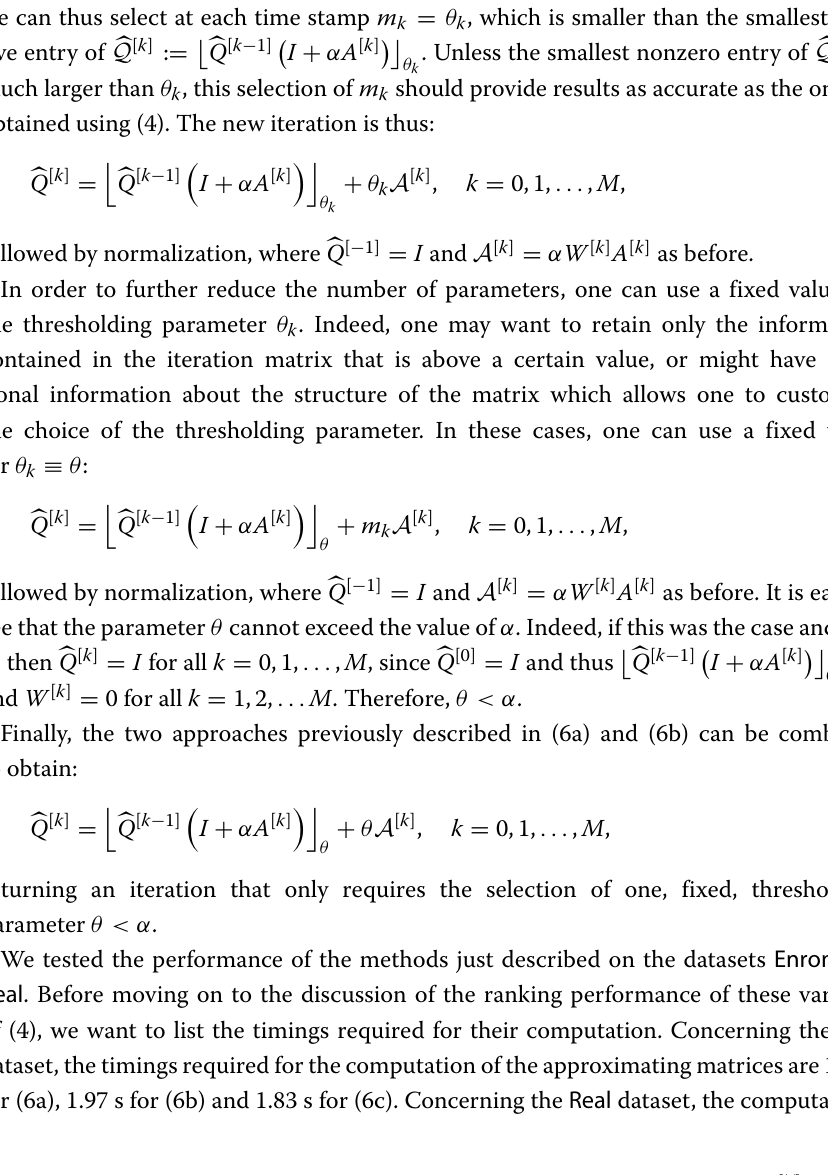
Table 8 FBsoc: intersection similarity between the top K = 1, 2, . . . , 20 ranked nodes in Q [ M ] 1 and (cid:12) Q [ M ]